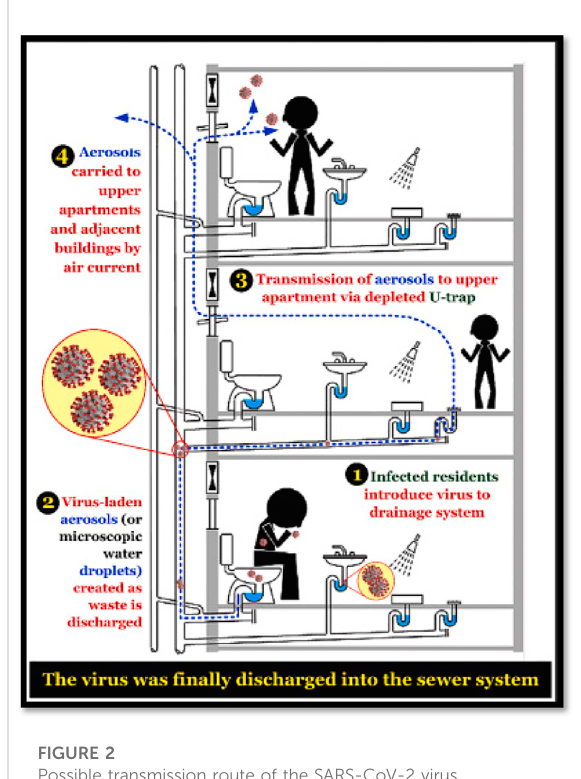
FIGURE 2 Possible transmission route of the SARS-CoV-2 virus, adopted from Tran et al. (2021).